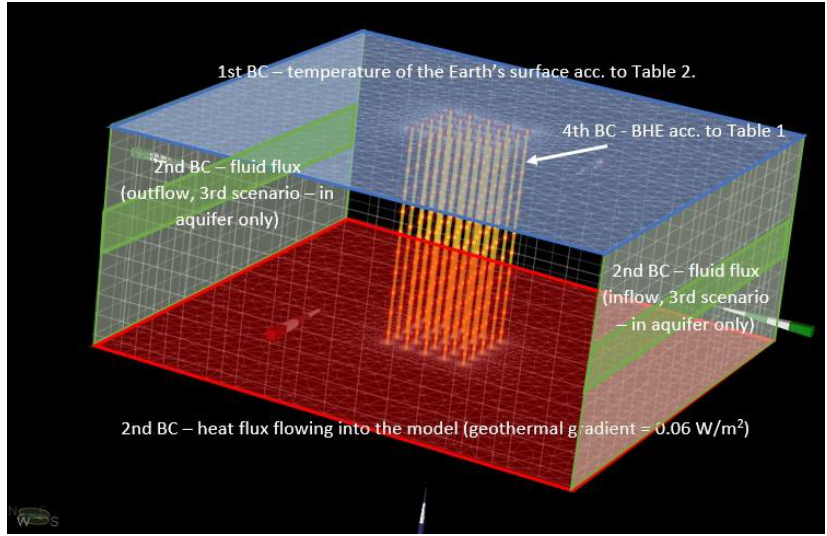
Figure 2. The scheme of boundary conditions applied to the model.